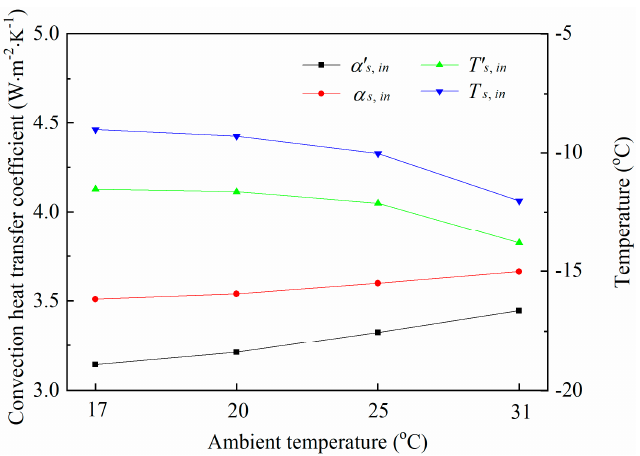
Figure 5. Inside heat transfer characteristics inside of the topside freezer wall at various ambient temperatures. Appl. Sci. 2020 , 10 , x FOR PEER REVIEW